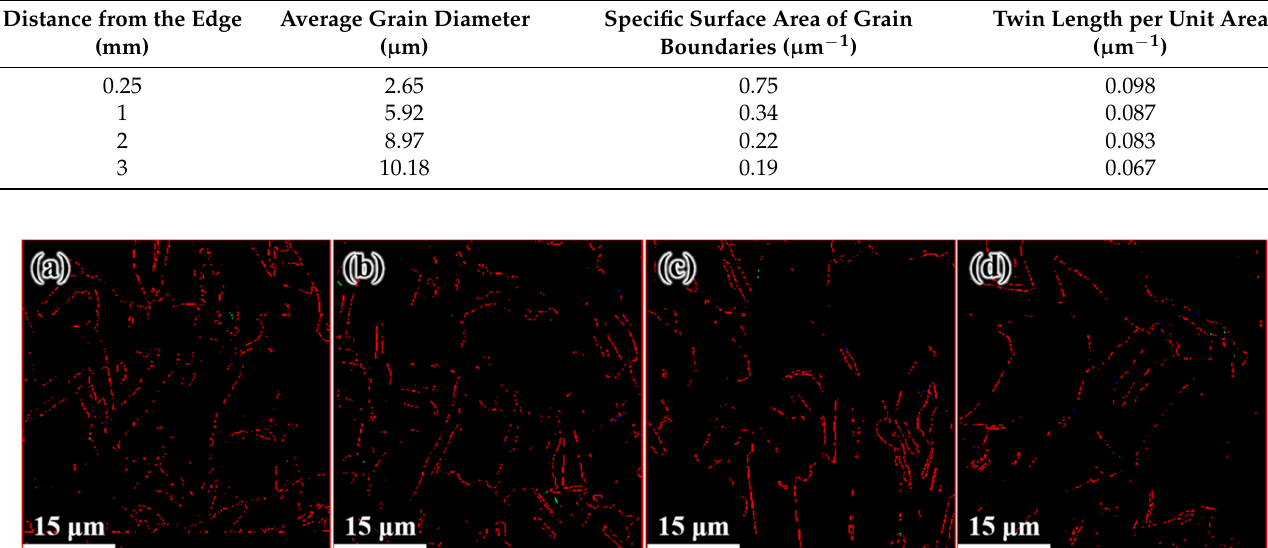
Figure 12. Distribution of microstructure after CE at room temperature: ( a ) 250 µ m from the edge, ( b ) 1 mm from the edge, ( c ) 2 mm from the edge and ( d ) 3 mm from the edge. Table 3. The average grain diameter, specific surface area of grain boundaries, and twin length per unit area after CE at room temperature.